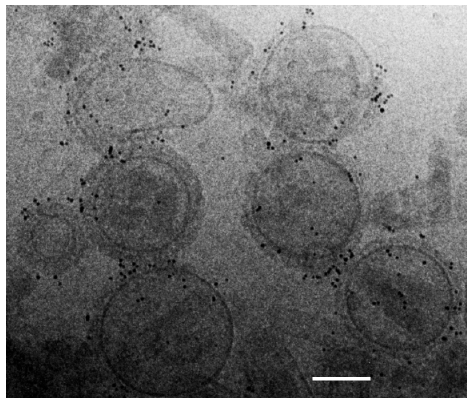
Figure 1. Cryogenic-transmission electron microscopy (cryo-TEM) of M2e5x virus-like particles (VLPs). Morphology and size of M2e5x VLPs were examined using cryogenic-transmission electron microscope (cryo-TEM). Mouse anti-M2e antibody (14C2) and 6 nm gold-conjugated goat anti-mouse antibodies were used as the primary and secondary antibodies to probe the M2e epitopes on VLPs. Bar scale: 100 nm.